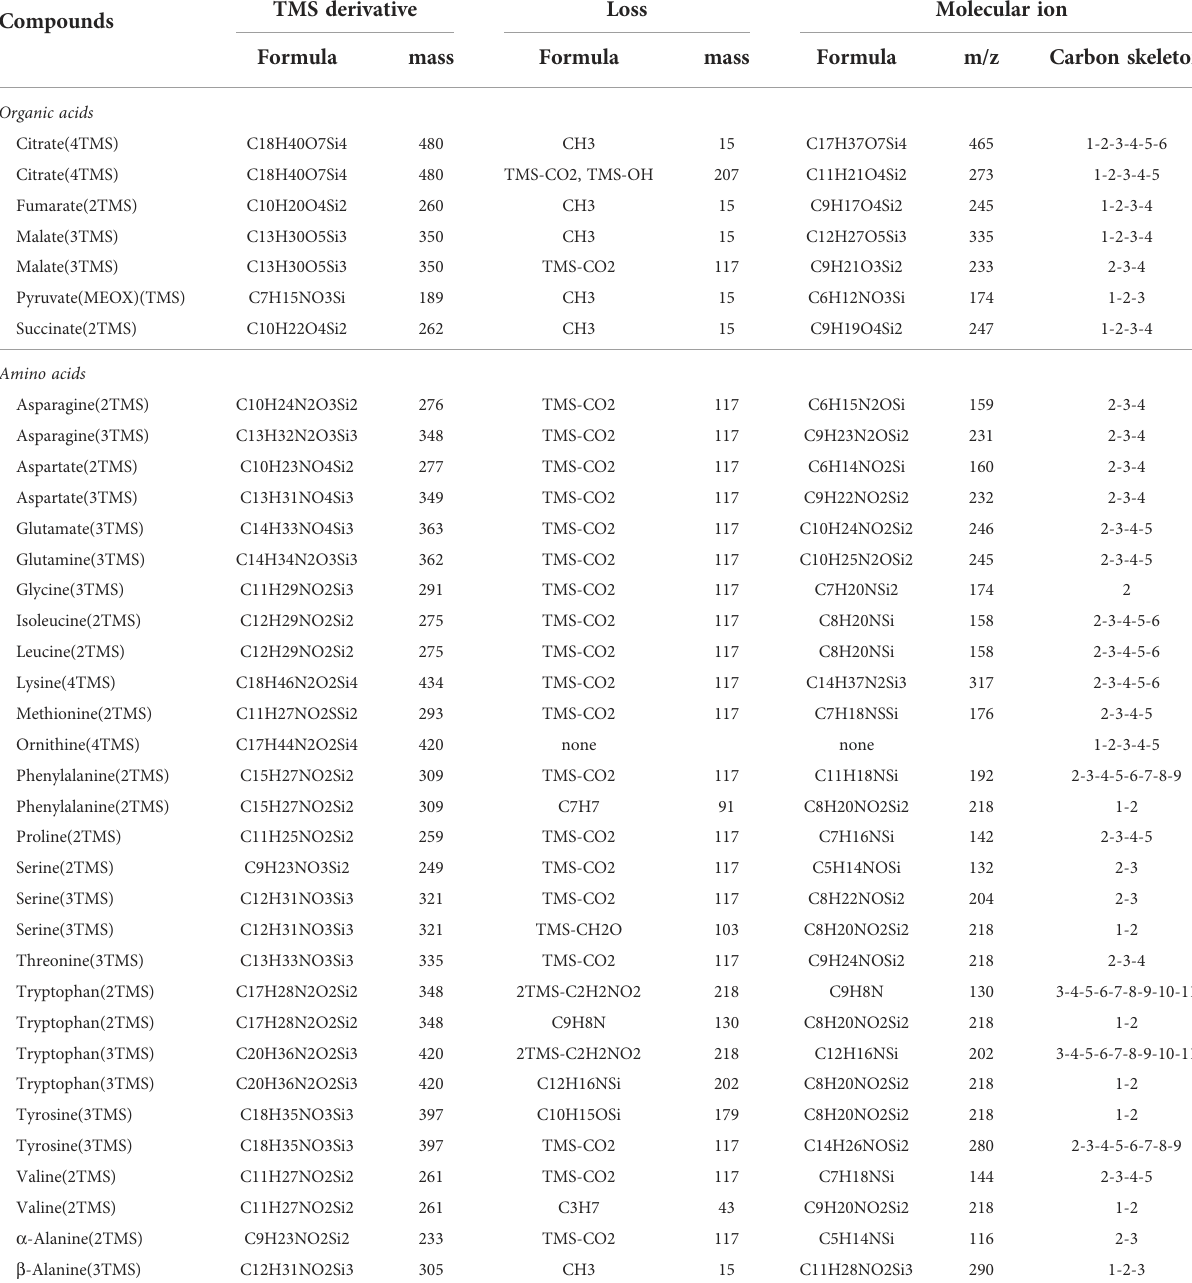
TABLE 1 Molecular ions selected for Carbon Isotopologue Distribution analysis of organic and amino acid TMS-derivatives by GC-MS.